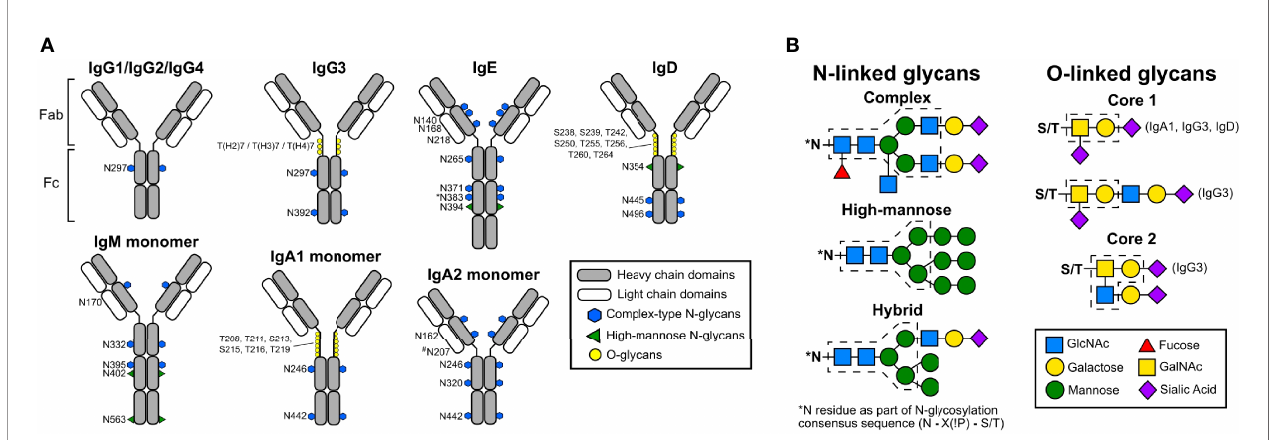
FIGURE 1 | Schematic representations of human antibody structures and attached glycans. (A) Human immunoglobulin structures with corresponding glycosylation sites (human numbering) are shown. Each antibody isotype is comprised identical heavy chains (gray) and light chains (white), forming the antigen-binding fragment (Fab) and fragment crystallizable region (Fc). While monomeric structures are shown, IgM typically multimerizes into a pentamers or hexamers, and IgA1 and IgA2 can form dimers. Blue hexagons denote sites occupied by complex-type N-glycans. Green triangles indicate sites occupied by oligomannose N-glycans. Yellow circles mark sites occupied by O-linked glycans. The N383 site on human IgE is unoccupied, and N207 on human IgA2 is present only in speci fi c allotypes. (B) Structures of N- and O- linked glycans found on human antibodies are represented. N-linked glycans are attached to asparagine residues containing the consensus sequence N-X-S/T. N-linked glycans can form complex, high-mannose, or hybrid types. Blue squares; GlcNAc. Yellow circles; galactose. Green circles; mannose. Red triangles; fucose. Yellow squares; GalNAc. Purple diamonds; sialic acid. Dashed lines indicate core structures, and sugar residues outside the core are variable